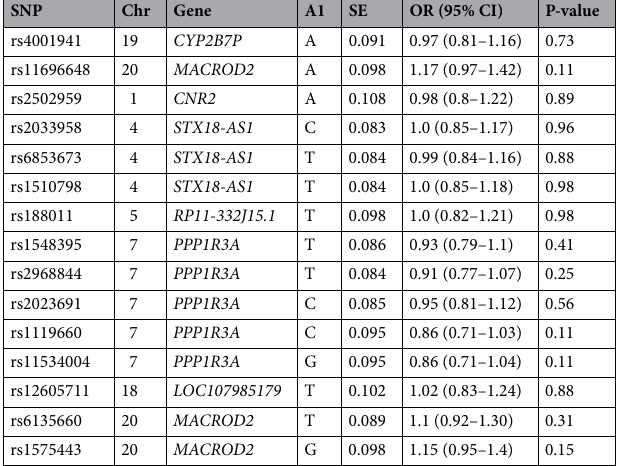
Table 3. Replication analysis of the suggestive GWAS loci with T2DM in UK-ROI cohort from Belfast, UK. A1: effective allele; Chr: chromosome; CI: confidence intervals; Cont: controls; MAF: minor allele frequency; OR: odds ratio, SE: standard